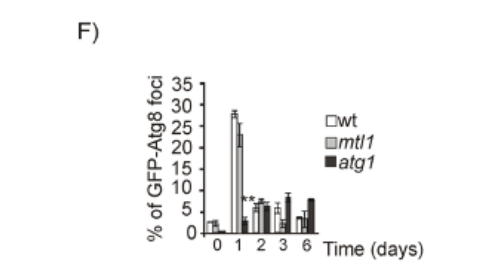
Figure 3. Mtl1 and Gcn2 control autophagy induction during glucose and amino acid starvation. Growth conditions, total Atg8 determination and autophagic flux determined in: ( A ) tor1 mutant expressing GFP–Atg8; ( B ) wt strain and ras2 mutant expressing GFP–Atg8; and ( C ) gcn2 mutant expressing GFP–Atg8, performed as described in Figure 1B. ( D ) gcn2 bearing GFP–Atg8 was exponentially grown at 30 ◦ C in SD plus amino acids. Rapamycin (200 ng/mL) was added to the cultures upon 1 day of growth and samples were subsequently collected upon 2, 6 and 24 h of exposure to the drug. Aliquots were treated as in Figure 1B. ( E ) Growth conditions, total Atg8 and autophagic flux determinations in mtl1 culture expressing the fusion protein GFP–Atg8 was performed as in Figure 1B. Identification of Atg1 protein in mtl1 cultures transformed with the plasmid Atg1HA was performed upon Western blot analysis using the anti-HA antibody as in Figure 1A. ( F ) Percentage of Atg8 foci quantified in the experiments, described in Figures 1A and 3E, was calculated upon microscopic observation of more than 1000 cells. The axis label “% of GFP–Atg8 foci” refers to the percentage of cells with GFP–Atg8 foci. Error bars in the histograms represent the standard deviation (SD) calculated from three independent experiments. Significance of the data was determinate by p -values from a Student’s unpaired t -test denoted as follows: * = 0.05 > p > 0.01; ** = 0.01 > p >